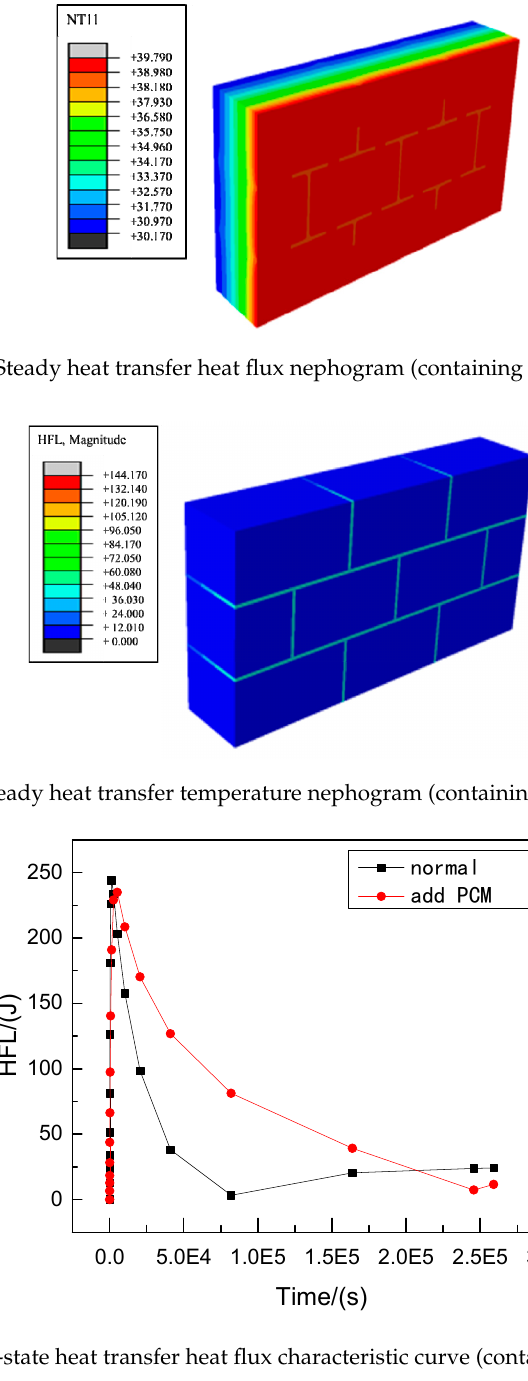
0.0 Figure 8. Steady-state heat transfer temperature characteristic curve (containing decanoic acid). It can be observed that, when the external wall’s ambient temperature and other conditions are the same, under the condition of steady heat transfer and with an increase in time, the masonry joint temperature with a 3.5% phase change material in the inner wall is always lower than that of the ordinary masonry joints, and the change in the maximum heat flux value of the former is less than that of the latter; that is, the heat transfer effect is more stable. Furthermore, the faster the heat flux is transmitted, the more heat flux is used to change the state of the phase change material, which leads to a reduction in the internal energy of the wall itself, and the temperature becomes lower. In conclusion, the composite phase change material masonry mortar can reduce the decline in the overall heat preservation performance of the wall to a certain extent compared with ordinary mortar. This phenomenon indirectly proves that the heat preservation performance of the phase change material used for masonry joints to reduce the thermal bridge effect is better, so the derived equation